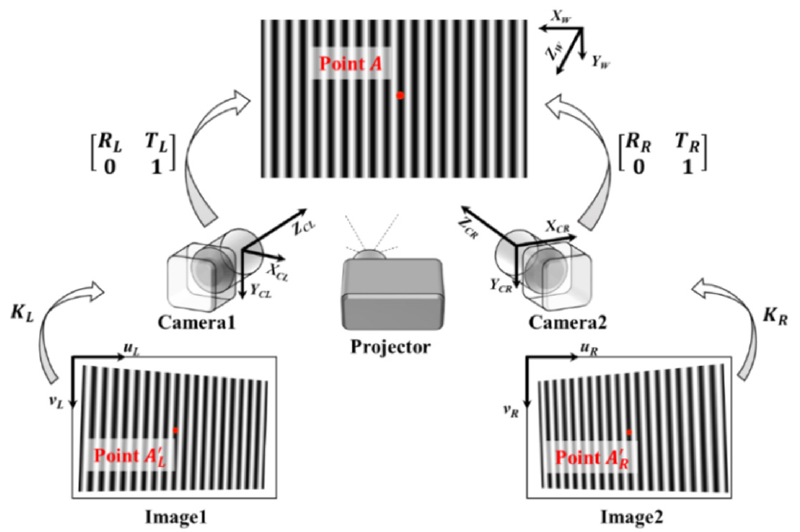
Figure 2. The binocular vision mode.